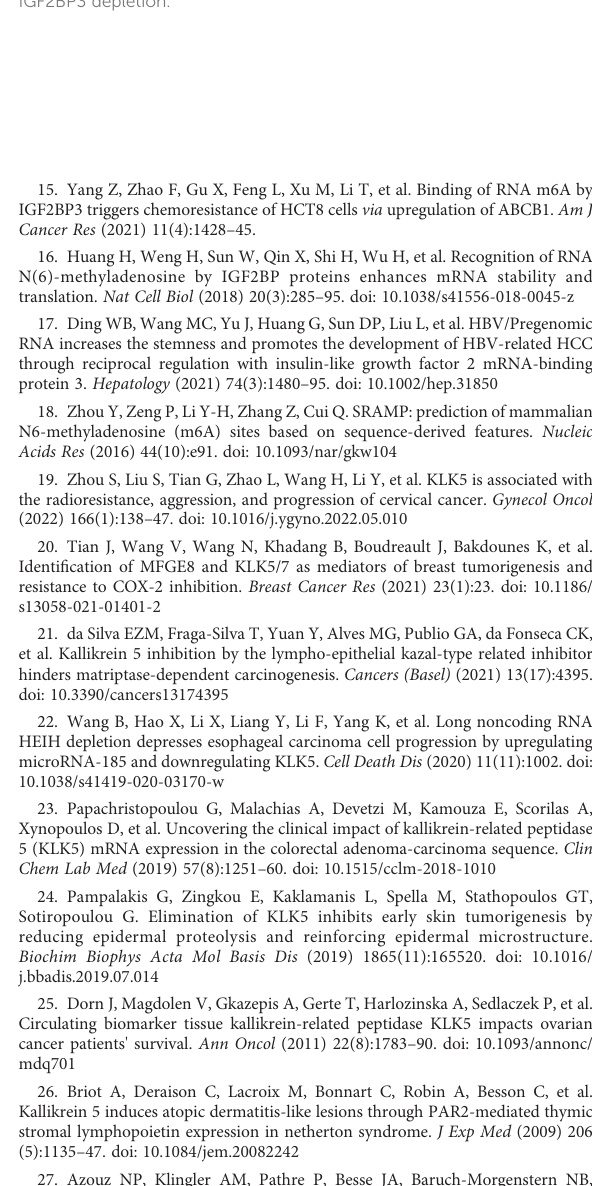
SUPPLEMENTARY FIGURE 1 IGF2BP3 overexpression enhanced GBC proliferation and migration (A, B) OCUG-1 cells were transfected with PLVX-IGF2BP3 and control plasmids, and effect of the transfection was veri fi ed by qPCR (A) and western blot (B, C – E) Cell growth ability was detected by performing CCK8 assay (C) , colony information assay (D) and EdU assay ( E , 100X, Hoechst (blue), Edu (red), scale bar: 100 m m) (F) Transwell assays were performed to measure the migration ability in treated OUCG-1 cells (40X, scale bar: 50 m m).